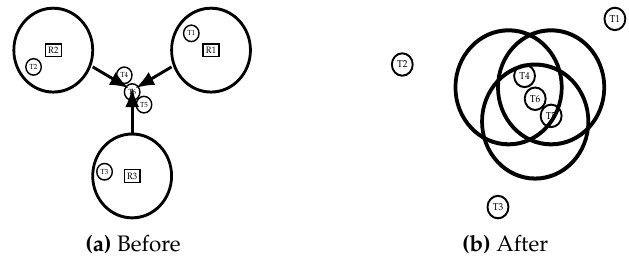
Figure 2. Mobility induced